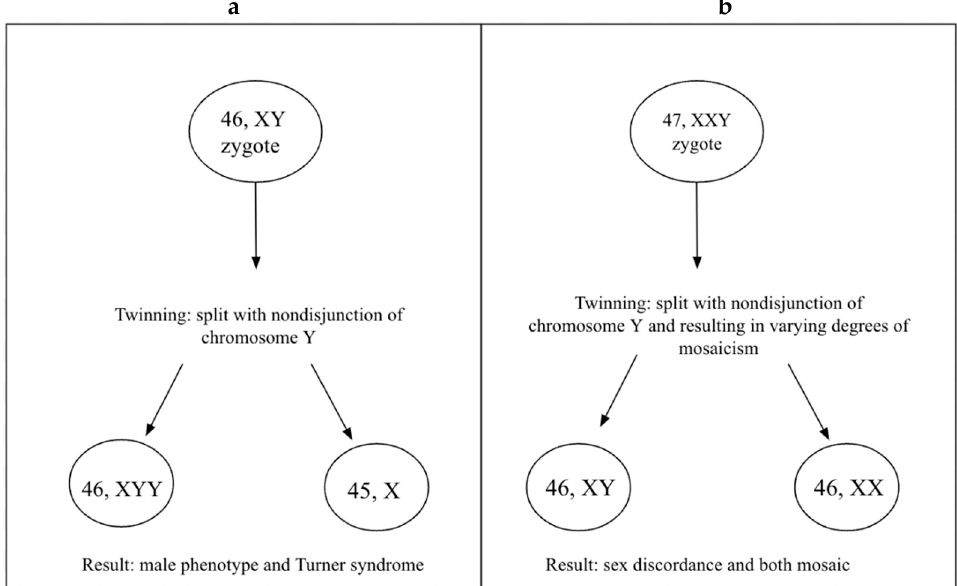
Figure 3. Mechanism of sex chromosome discordance. ( a ) Turner syndrome. ( b ) Monozygotic twinning resulting in 46, XX and 46, XY karyotypes.